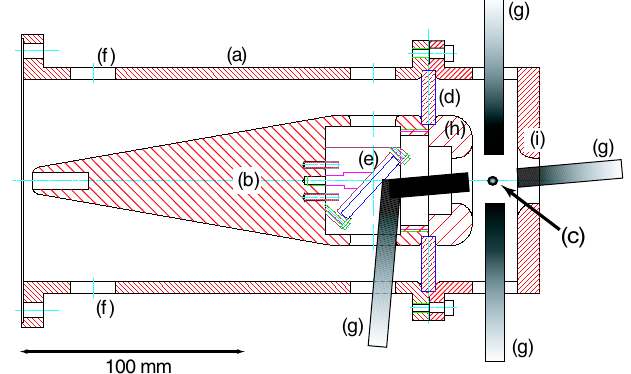
FIG. 1. (Color) Technical drawing of the accelerator (cross section): inner conductor; (c) acceleration point; (d) glass ring; (e) mirror; (f) pumping holes; (g) laser beams; (h) radius of curvature on the inner ; (i) radius of curvature at the acceleration point R conductor R i